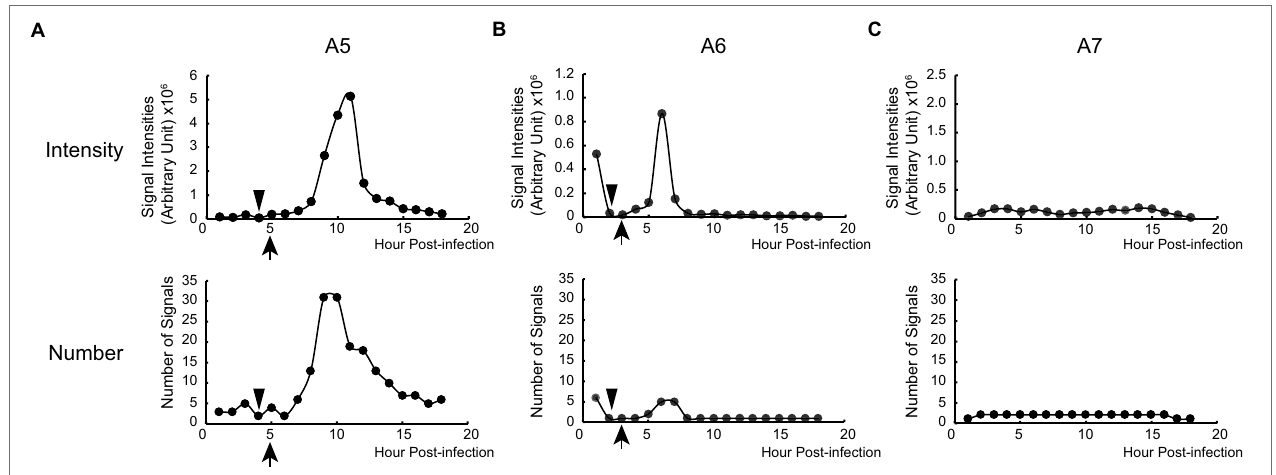
FIGURE 5 | Replication of PB2-vMSL vRNA after IAV infection. The intensity and number of punctate RDs in each z-plane of representative Cells A5 (A) , A6 (B) , and A7 (C) during the entire 18-h imaging period were measured using the Computer-Assisted Plasmid Summation (CAPS) program, and then counted, summed up, and graphed. Triangles indicate when apoptosis was first observed, and arrowheads indicate when vRNA replication was observed to